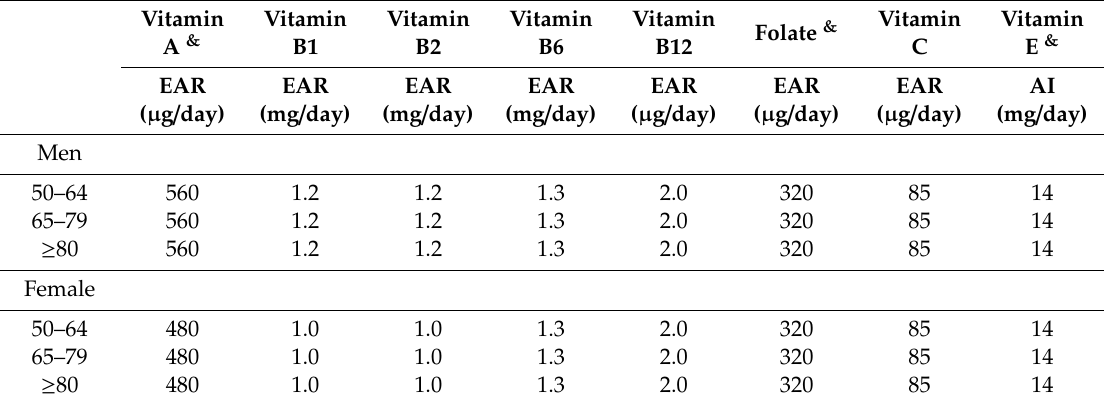
Table A1. EARs or AIs for selected vitamins for Chinese elderly *.